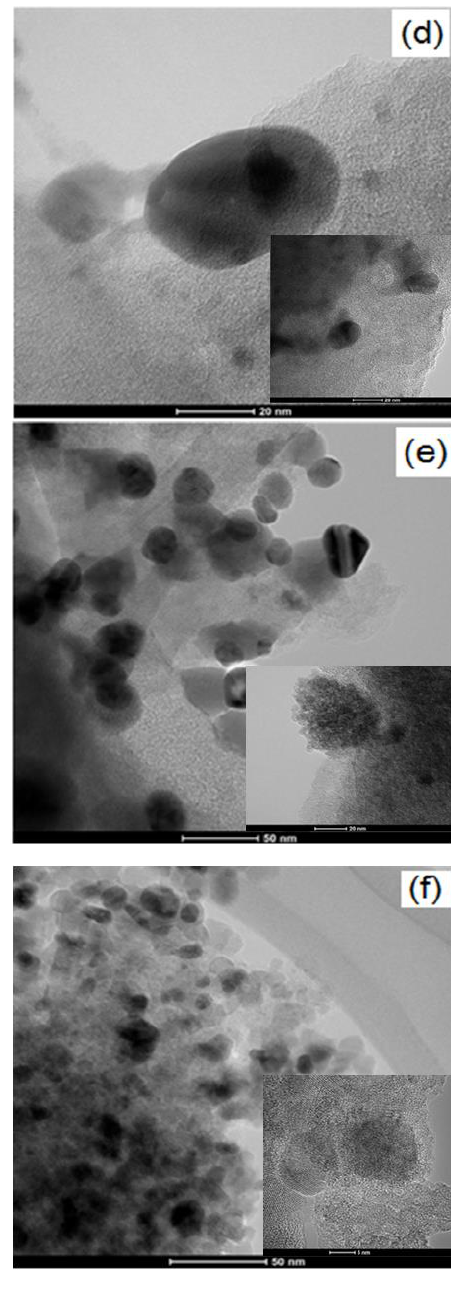
Figure 2. SEM images of ( a ) AgZnS; ( b ) AgZnS-G; ( c , d ) AgZnS-G-T photocatalysts. TEM images of ( d ) AgZnS; ( e ) AgZnS-G; ( f ) AgZnS-G-T